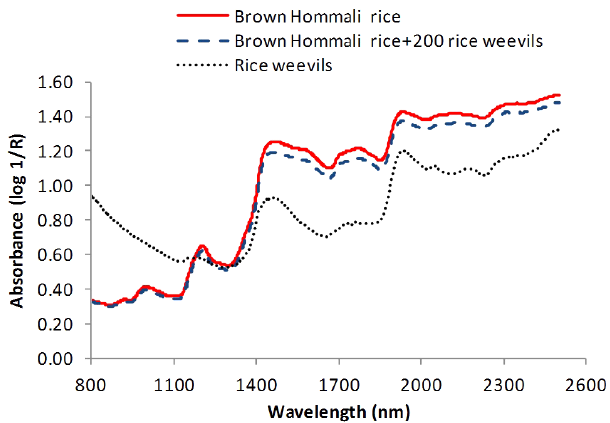
Fig. 4. Raw absorbent spectra of 100% brown Hommali rice, 200 rice weevils infested and 100% rice